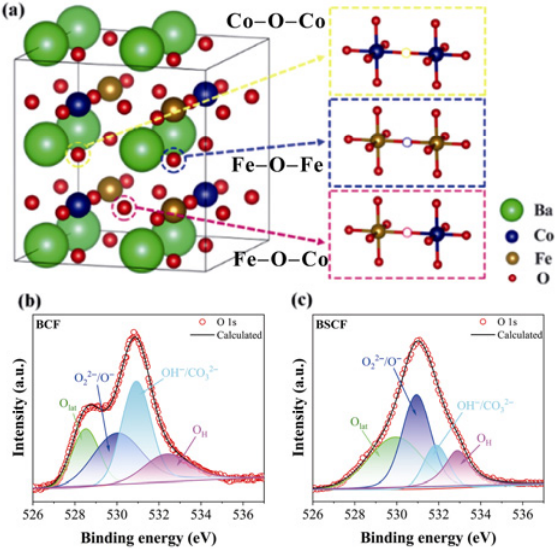
Fig. 3 (a) DFT calculated configuration for BCF; O 1s XPS spectra for (b) BCF and (c) BSCF.